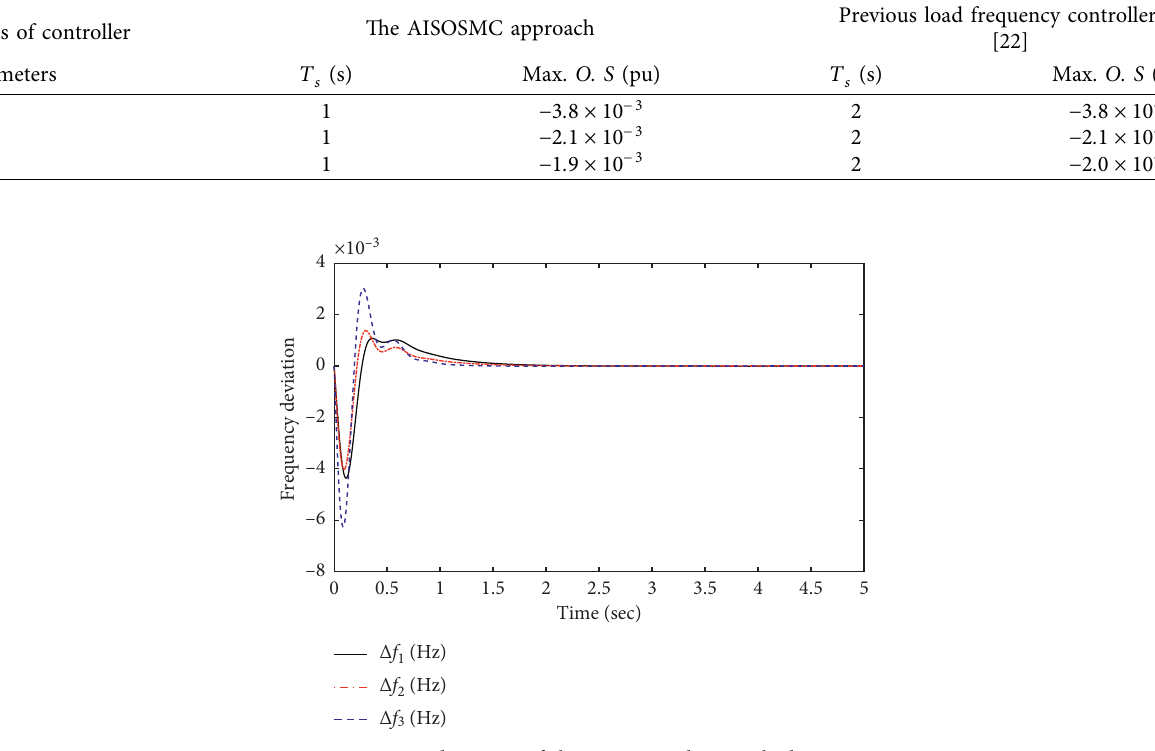
Figure 5: Frequency deviation of the system under matched